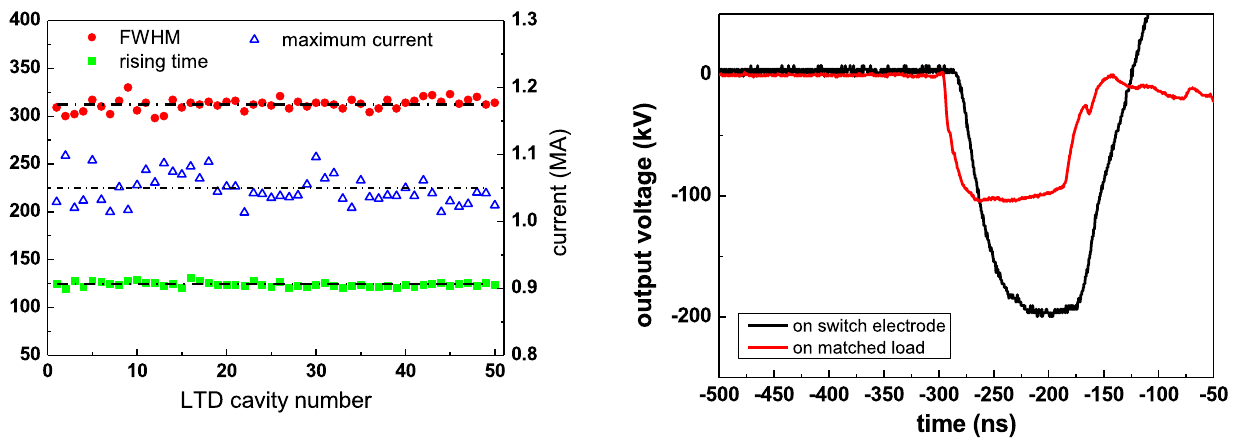
FIG. 19. Comparison of trigger output at the cable end from testing. Avoltage with a maximum of 103 kV, rising time of 20 ns is obtained on a matched load. On the electrode of the switch, the maximum is 195 kV, and the rising time is 40 ns.